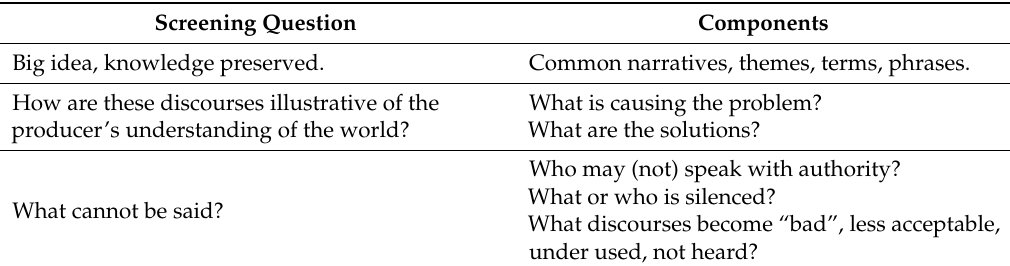
Table 2. Screening Questions for Narrative Profiles.